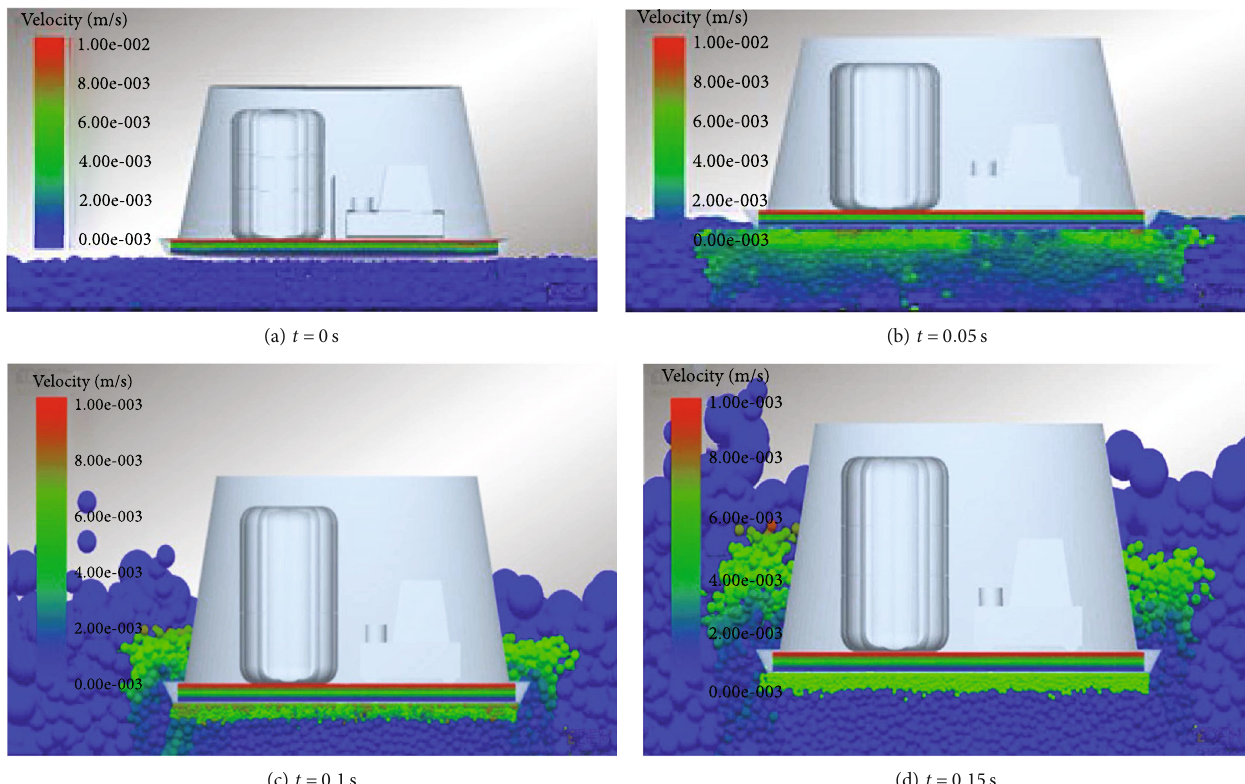
Figure 19: The landing simulation process of the whole lander.